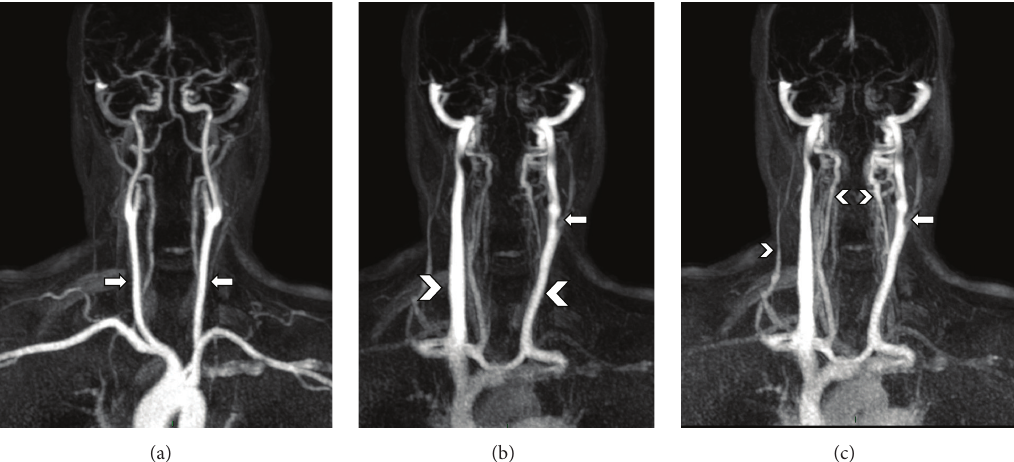
Figure 4: Time-resolved MRV (4D-TRAK), reconstructed as coronal MIP projections at different time points, showing (a) arterial phase with carotid axes (arrows), (b) venous phase with visualization of IJVs (arrow heads), with a segmentary stenosis of left IJV (arrow), and (c) a delayed venous stage with better visualization of venous drainage of right external jugular vein and vertebral veins (arrow heads) and a confirmation of the left IJV stenosis from the previous phase